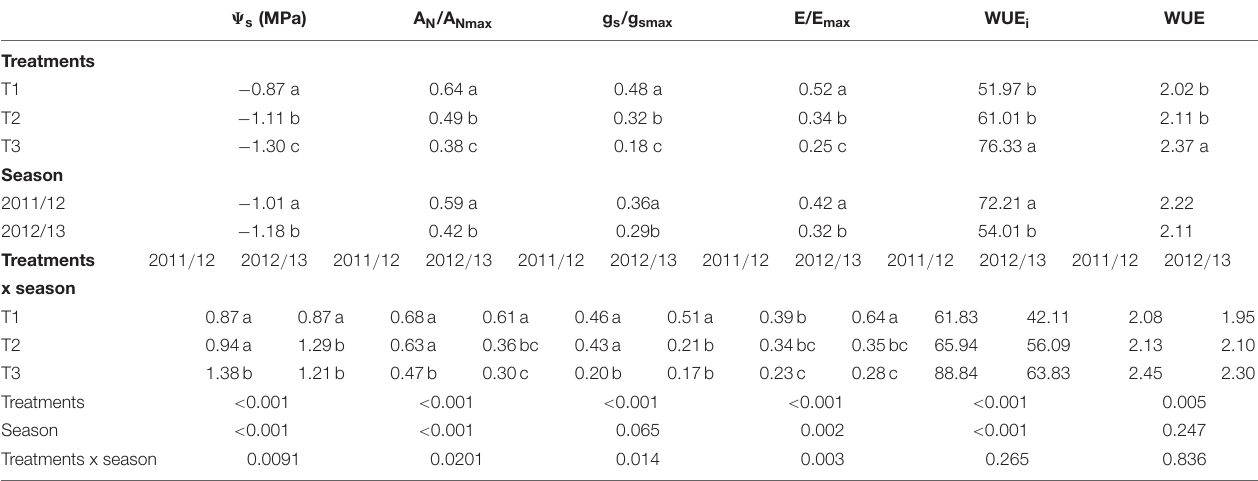
TABLE 6 | Effect of three levels of water application on physiological variables from veraison (V) to harvest (H) period on a Drip-irrigated Carménère